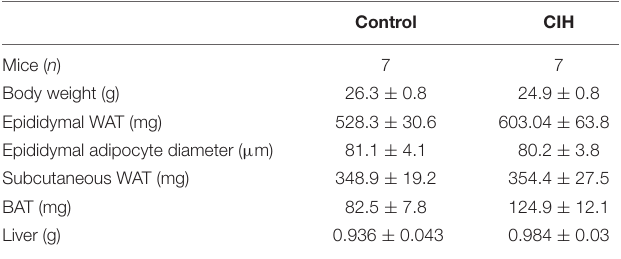
TABLE 1 | Baseline characteristics of mice exposed to 6 weeks chronic intermittent hypoxia (CIH) or normoxia (N). g, gram; mg, milligram; µ m,